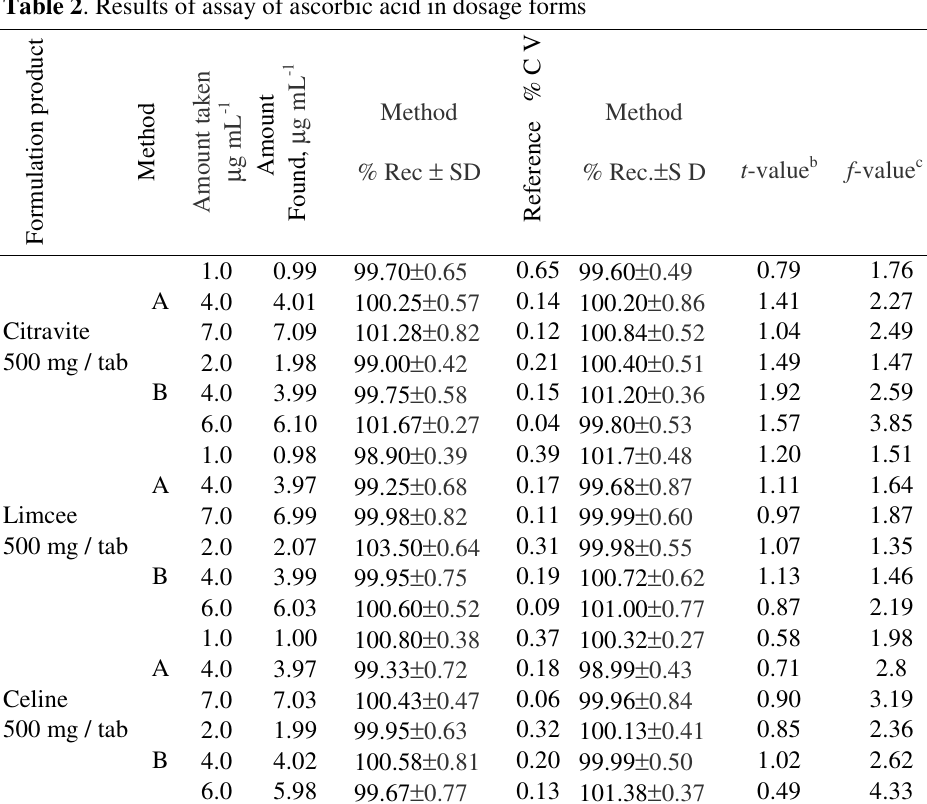
Table 2 . Results of assay of ascorbic acid in dosage forms